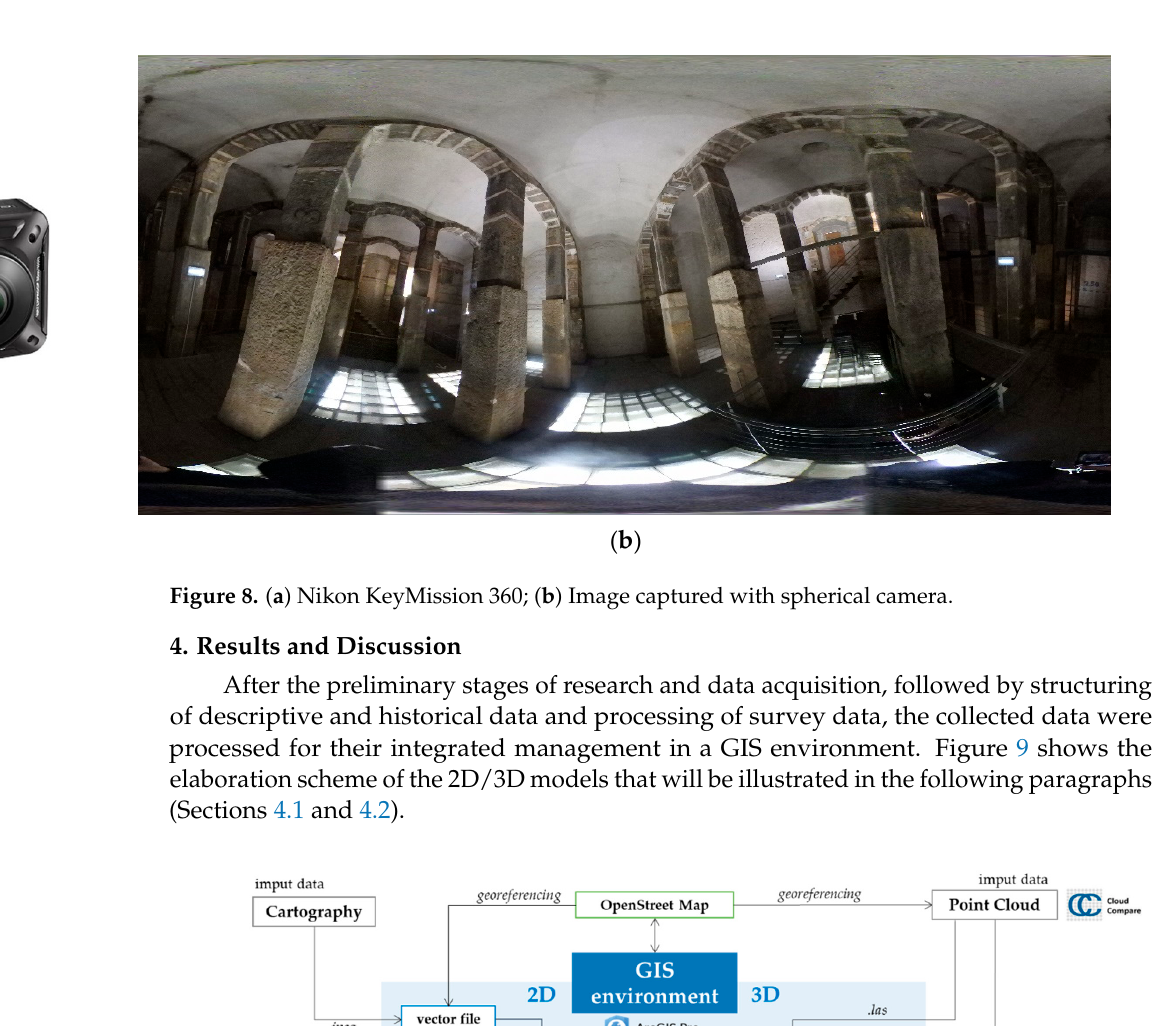
Figure 7. ( a ) Nikon D5500 camera; ( b , c ) Images captured with reflex camera.